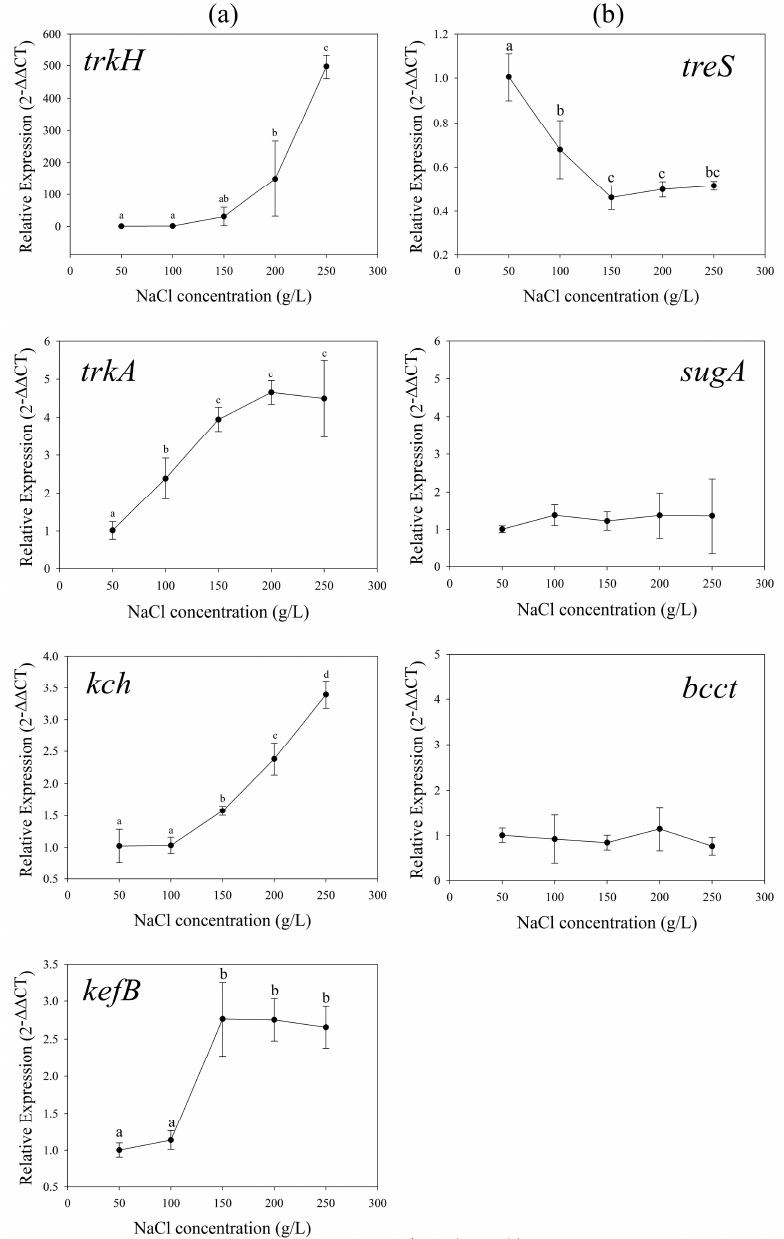
Figure 3. The relative expression levels of potassium uptake genes trkH , trkA , kch and output gene kefB ( a ), amylase/trehalose synthesis gene treS , compatible solutes transport genes sugA and BCCT family gene ( b ) in different salt concentration without exogenous compatible solutes.